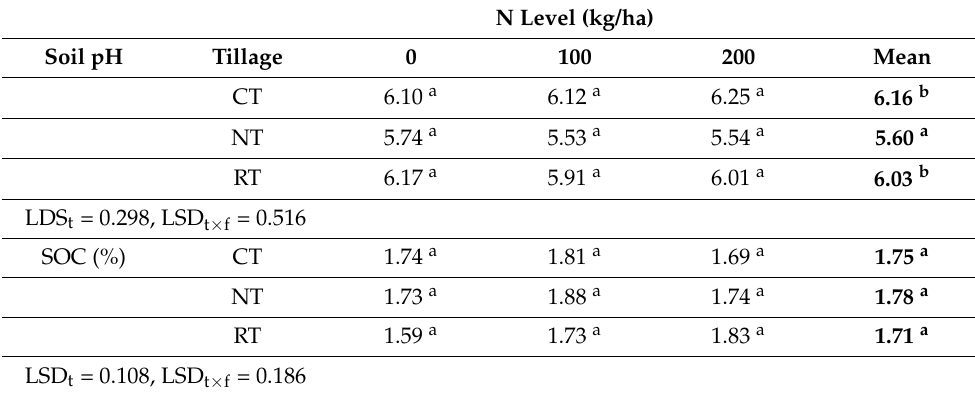
Table 3. The concentration of soil organic carbon (SOC) and soil pH at different N fertiliser levels under three tillage treatments (NT, CT, and RT) after 17 years of trial establishment.